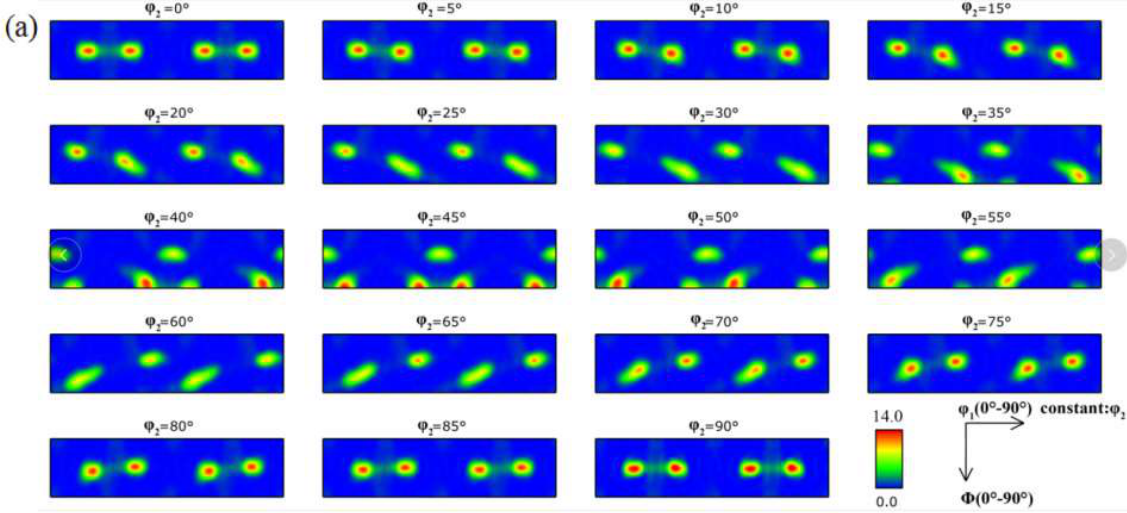
Figure 6. Effect of annealing time on the grain size of rolled and annealed copper foil. ( a )